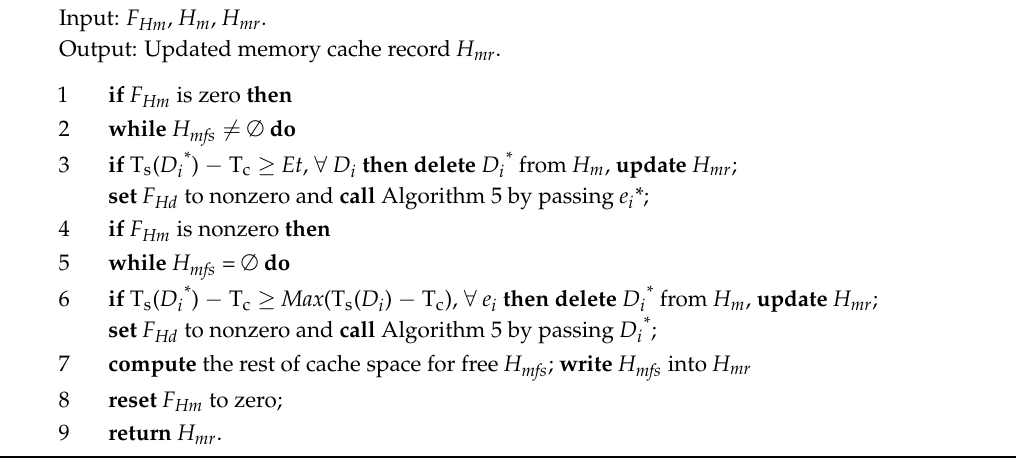
Algorithm 2. Delete out-of-date data in the memory cache